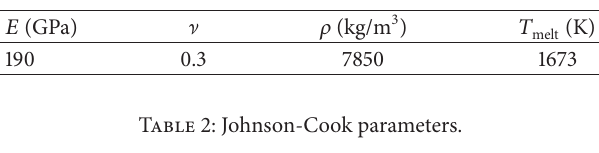
Figure 1: Resulting stress-strain behavior after the calibration of the CD and UD models based on uniaxial stress and pure shear deformation test with the applied loading rates 1000 and 2500 s −1 . Table 1: Material properties pertinent to elastic and thermal response.